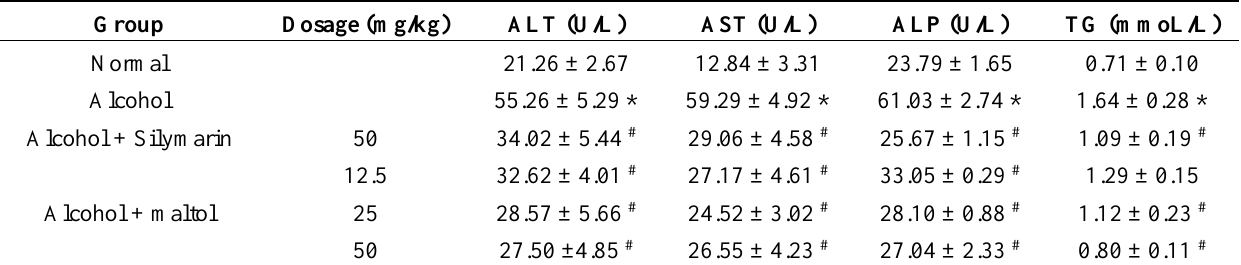
Table 2. Effects of maltol on serum ALT, AST, ALP and TG levels in mice.